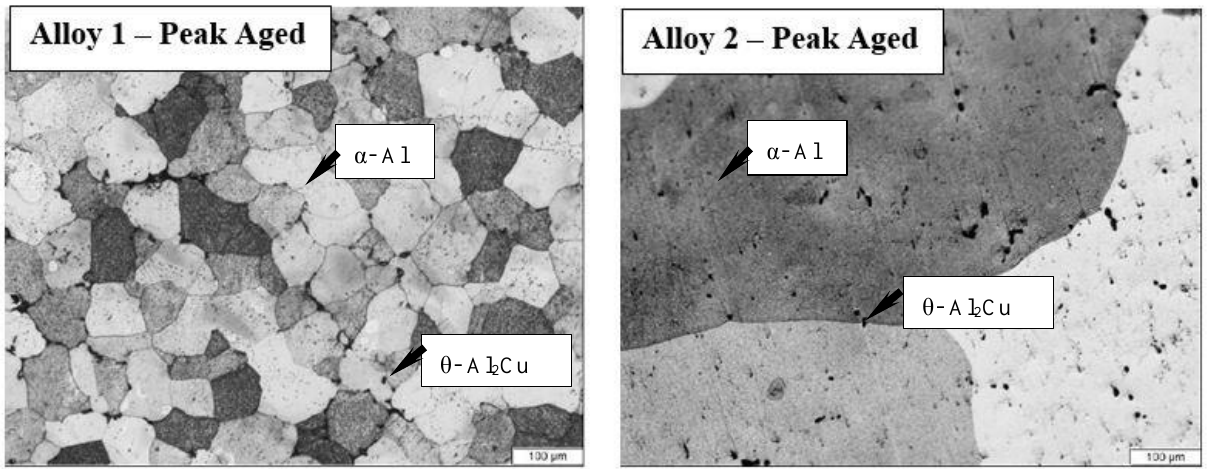
Figure 7. Cross-sectional optical microscopy (OM) observations of the peak-aged treated (PA) Al-Cu-Mg-Ag alloys.